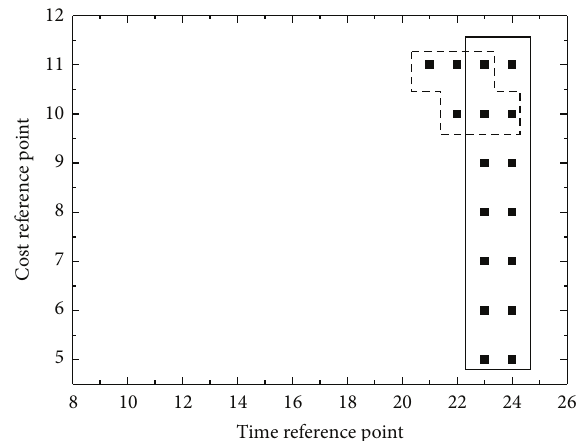
Figure 14: Possible reference points of carpooling success with traffic congestion rate